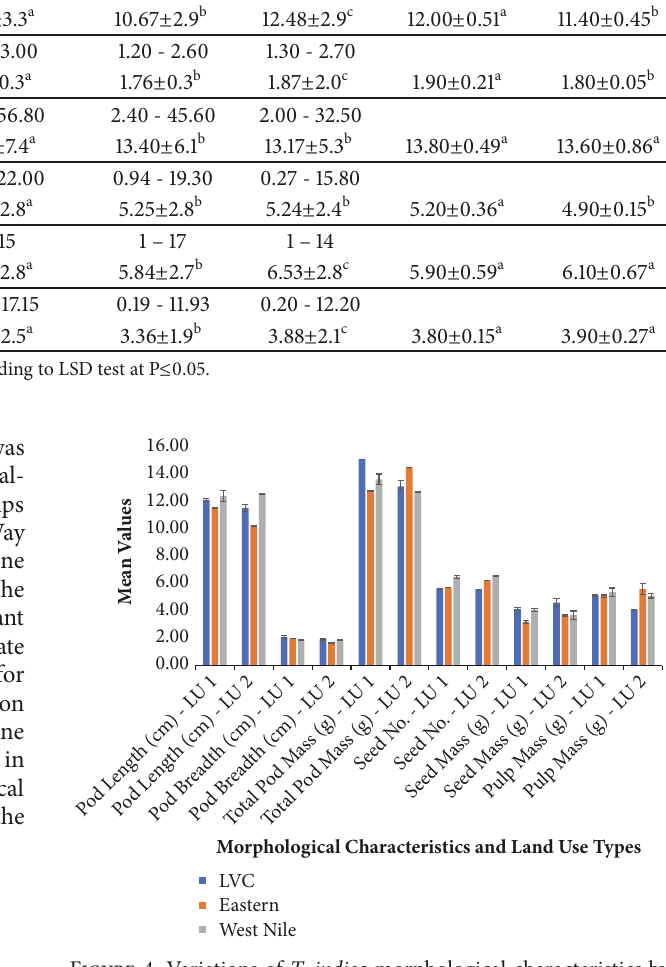
Figure 4: Variations of T. indica morphological characteristics by land use types. Key : LU 1, land use 1 (wild); LU 2, land use 2 (on-